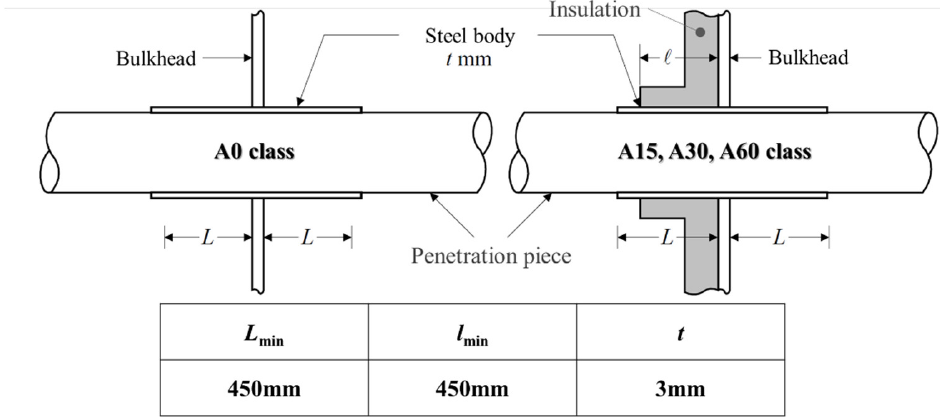
Figure 1. The fire-resistance rating of A-class bulkhead penetration piece.